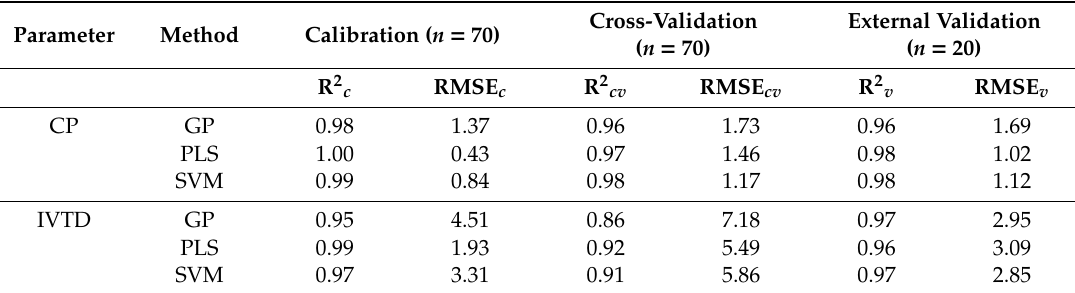
Table 5. Calibration, cross-validation, and external validation statistics obtained for crude protein (CP) and in vitro true digestibility (IVTD) in pigeon pea using three calibration techniques. Parameter Method Calibration ( n =